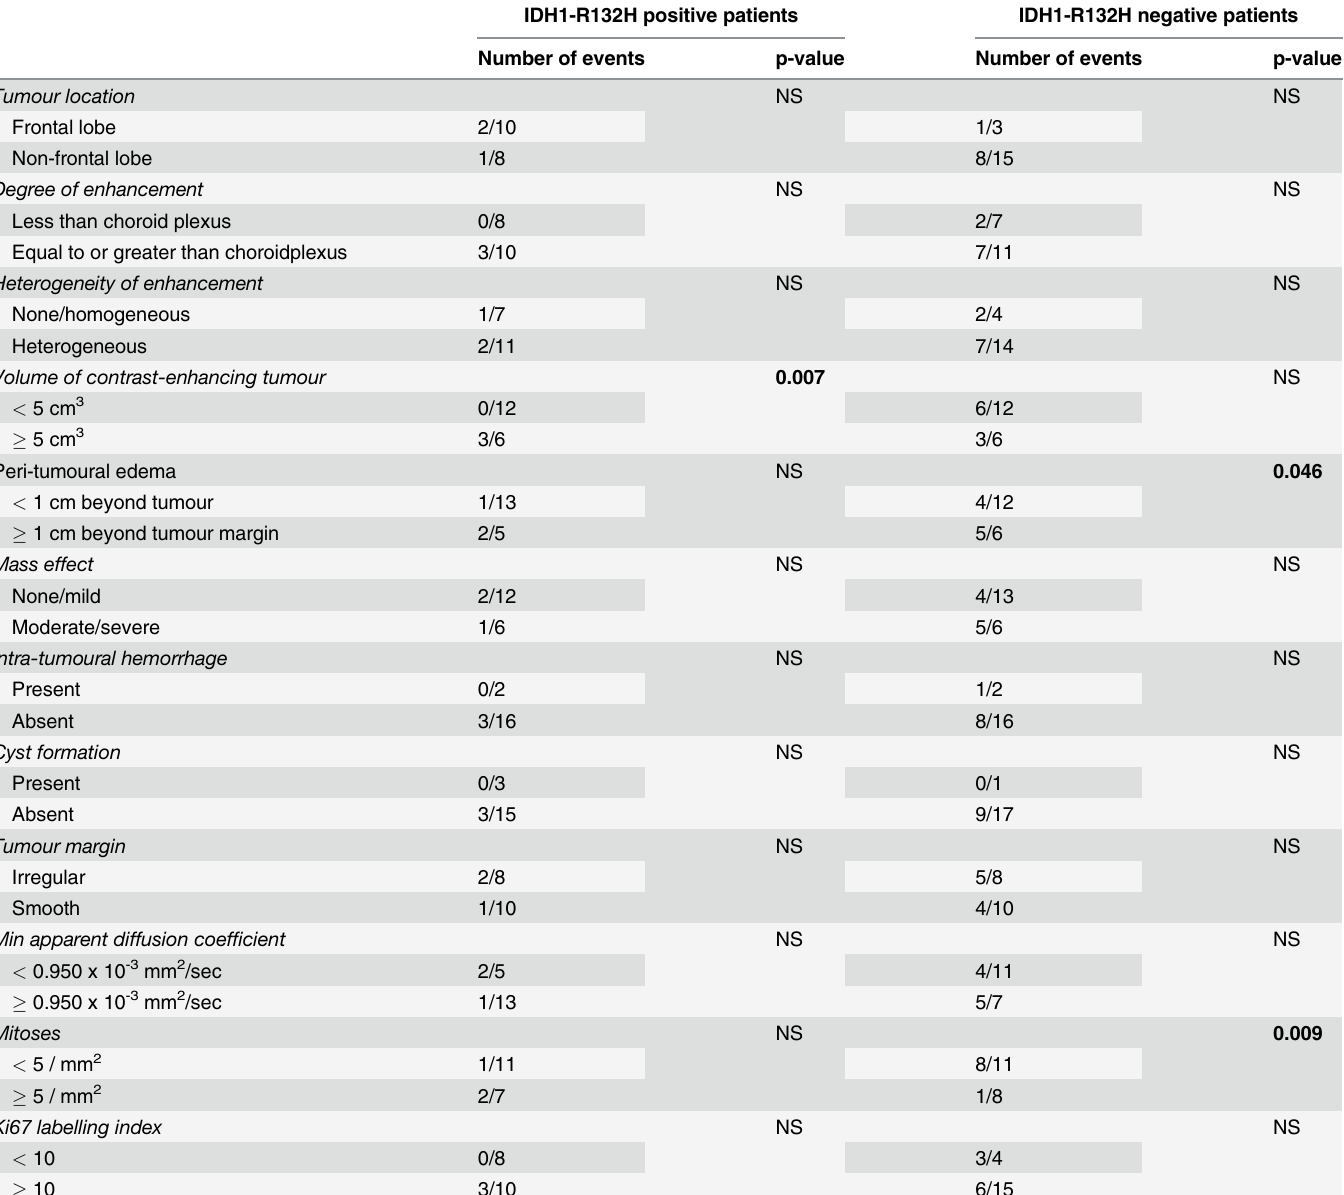
Table 3. Association between radiological features, markers of cellular proliferation, and early mortality in patients with newly diagnosed anaplas- tic astrocytic